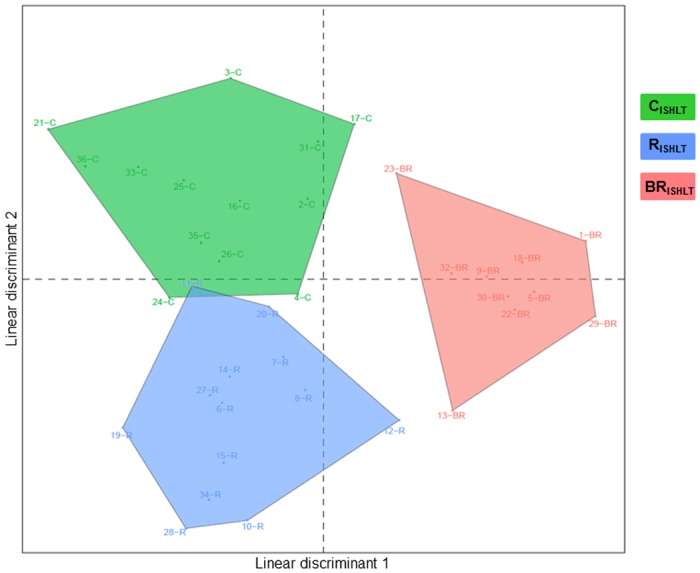
Representation of Linear discriminant analysis of CISHLT, RISHLT and BRISHLT samples.Expression profiles were restricted to the set of 15 probes.